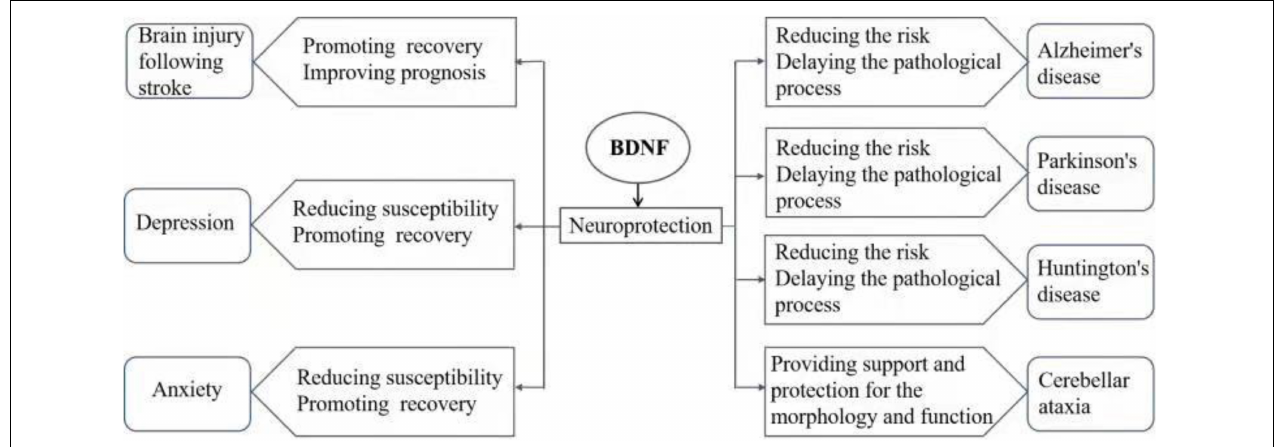
FIGURE 1 | The role of BDNF signaling in CNS disease